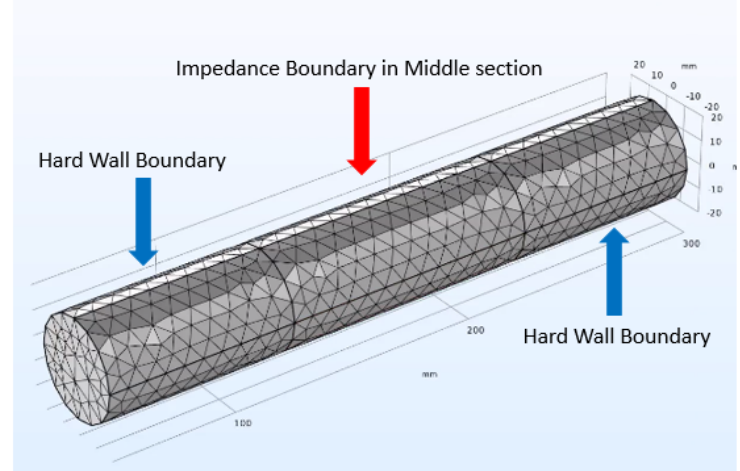
Figure 9. Impedance test.